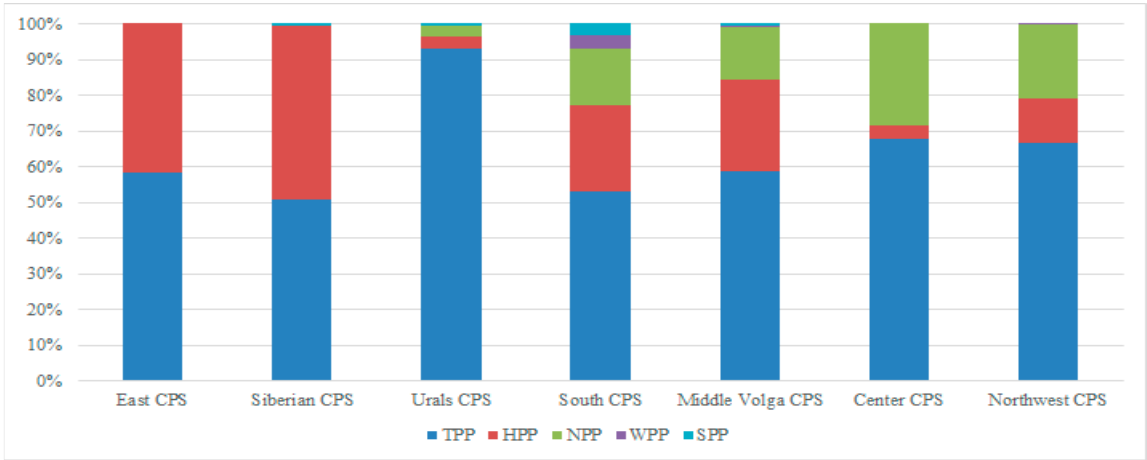
8 of 19 Figure 2. Power plants of the Russian Federation (1—structure of power plants by type of generating equipment; 2—structure of TPPs by fuel types; 3—structure of TPPs by type of generating equip- ment): HPP—hydroelectric power station; NPP—nuclear power plant; WPP—wind power station; SPP—solar power plant; TPP—thermal power plant; CCGT—combined-cycle gas plant; GTP—gas turbine plant; SPP—steam power plant (Source: Report on the functioning of the UES of Russia in 2020). The Russian Federation is also characterized by significant territorial unevenness of